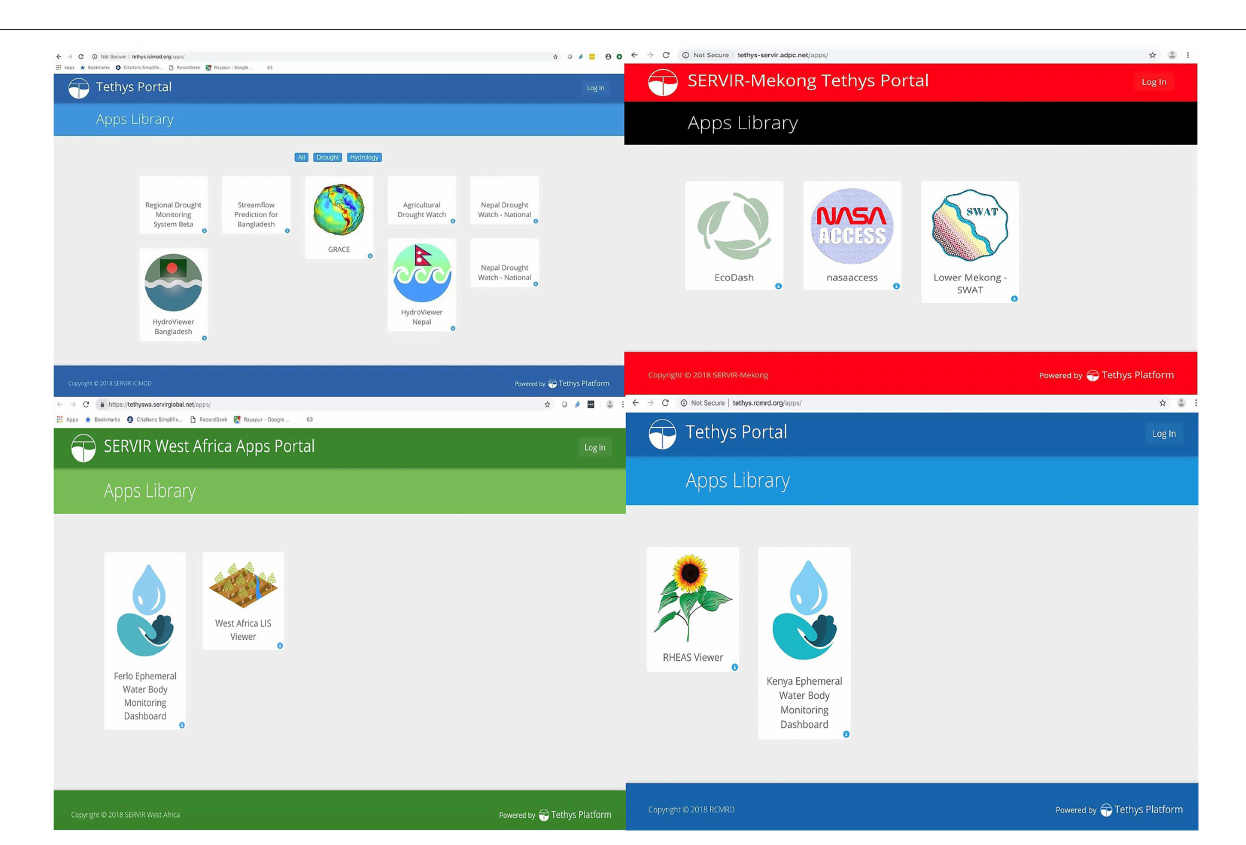
and the Tethys application enables quick prototyping and deployment of the applications within the portal framework leading to additional Tethys portals in all of SERVIR’s hubs ( Figure 13